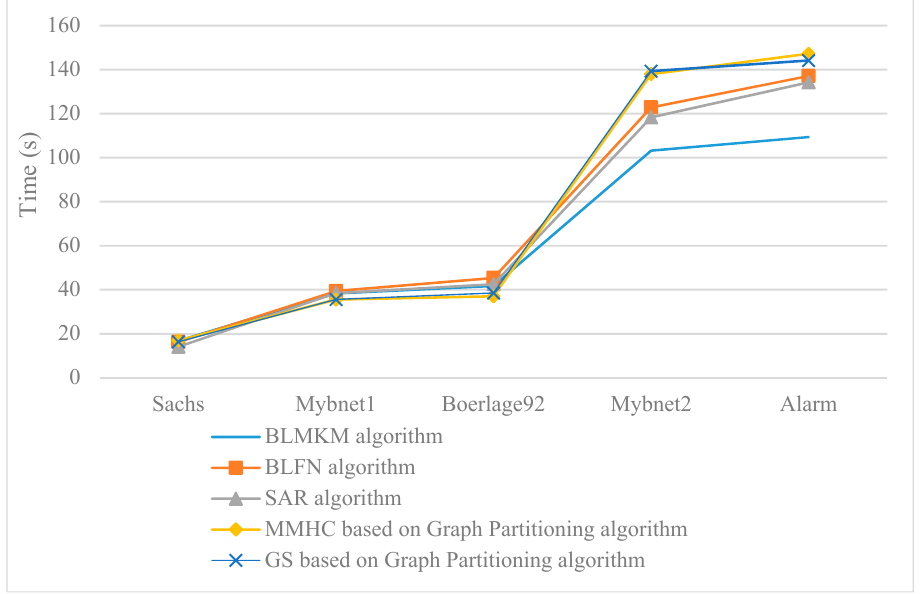
Figure 8. The comparison of running time between BLMKM algorithm and other block learning algorithms.